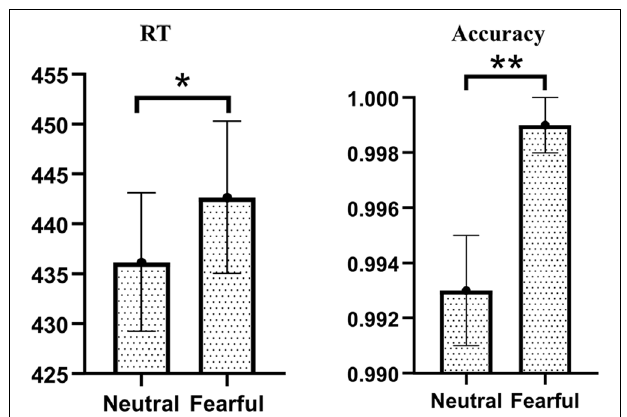
FIGURE 2 | Behavioral results of visual target stimuli. There were significant main effects of Emotion on RT and accuracy. Compared with neutral facial expressions, the response of fearful facial expressions was slower but more correct (* p < 0.050; ** p < 0.010).